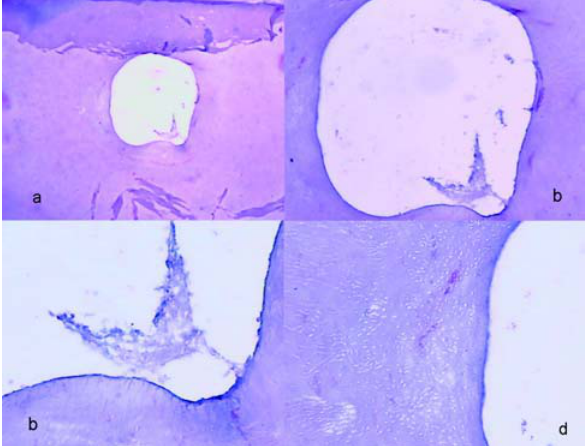
FIGURE 5- Group V- F2 instrument associated with distilled water irrigation (HE, a-40x; b-100x; c and d-200x)